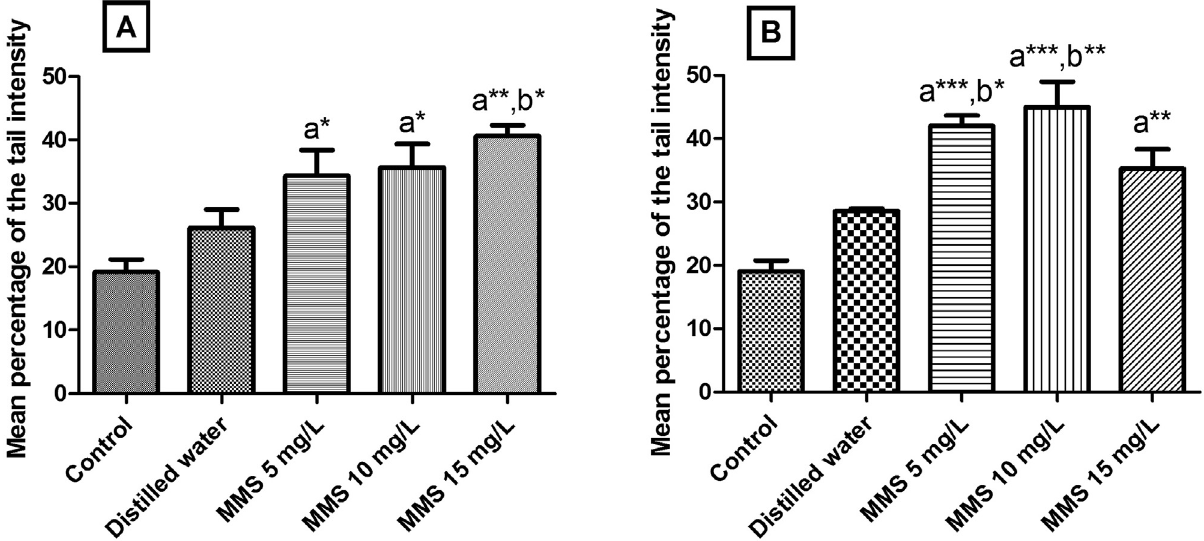
Figure 2 - Mean percentage of tail intensity of nucleoids from Oryza sativa L. exposed to different concentrations of methyl methanesulfonate (MMS). A ) accession BGA012099 “Ferrinho”. B ) accession BGA008070 “Primavera”. The data are represented as means (cid:4) SEM. Control = seeds not exposed to MMS or to distilled water. a Significant in relation to control. b Significant in relation to distilled water group. One-way ANOVA followed by Tukey test